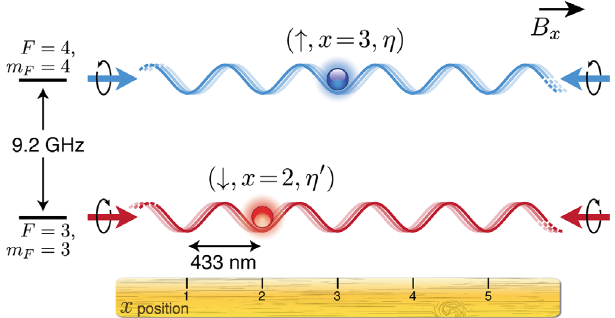
FIG. 1. Transport of single Cs atoms in state-dependent periodic potentials. Two independent optical lattices originate from standing waves of opposite circular polarization but identical wavelength λ ¼ 866 nm. Depending on the internal state, ↑ or ↓ , atoms experience one or the other lattice potential. An optoelectronic servo-lock loop allows the position of each lattice to be arbitrarily controlled. The atom ’ s position is retrieved with single-site resolution by fluorescence imaging. The param- eter η accounts for other degrees of freedom, such as the atom ’ s position perpendicular to the lattice or, in general, other hidden physical aspects. The quantization axis is defined by the small bias magnetic field B x , which is chosen along the two optical lattices. F and m F denote, respectively, the total angular mo- mentum and its projection along the quantization axis for both internal hyperfine